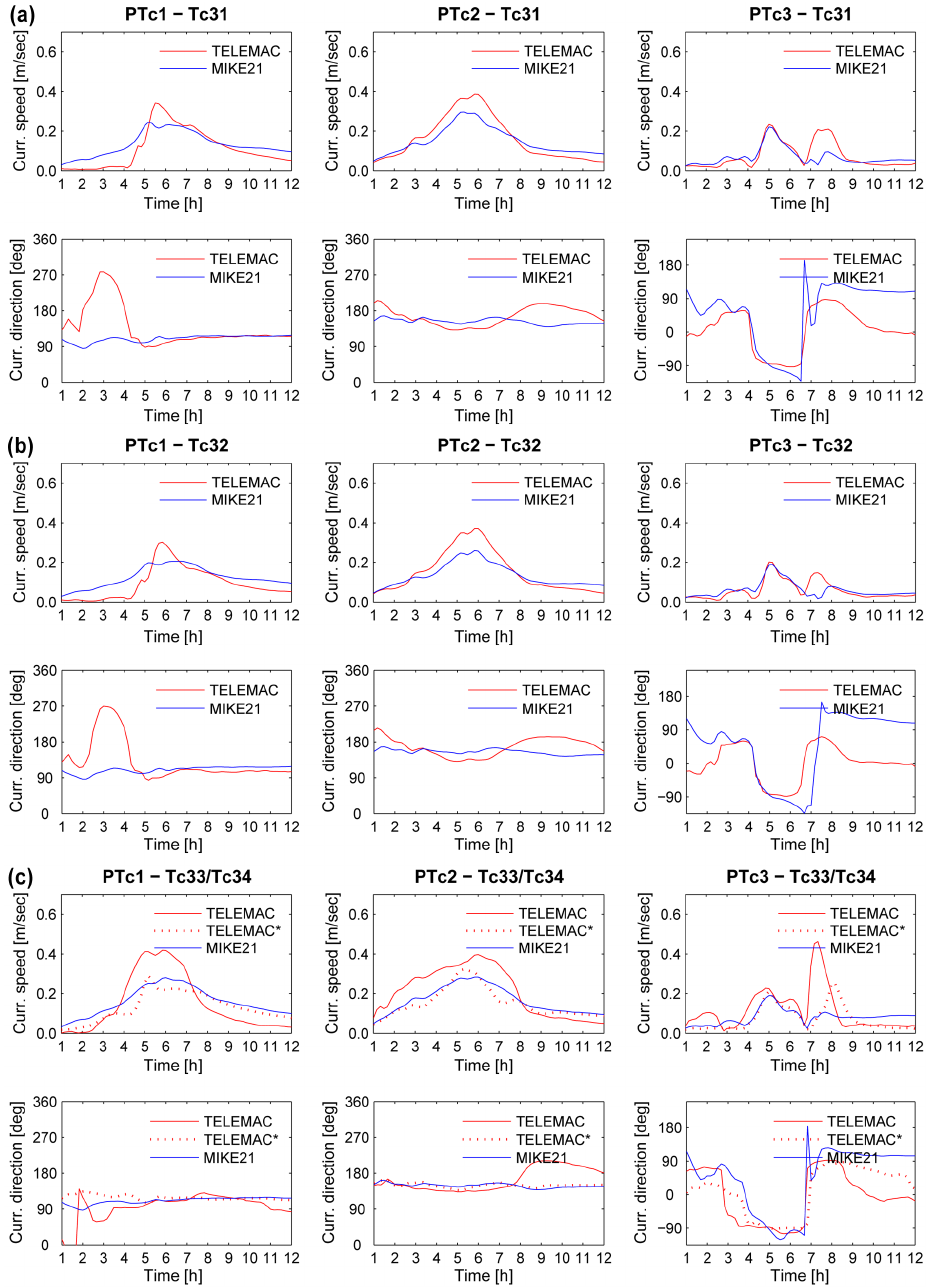
Figure 10. Comparison of TELEMAC and MIKE21 results (Curr. speed/direction) at points within the breaker zone (PTc1, PTc2, PTc3) for the Brindisi–Torre Guaceto case study for runs (a) Tc31, (b) Tc32 and (c) Tc33/Tc34 ∗